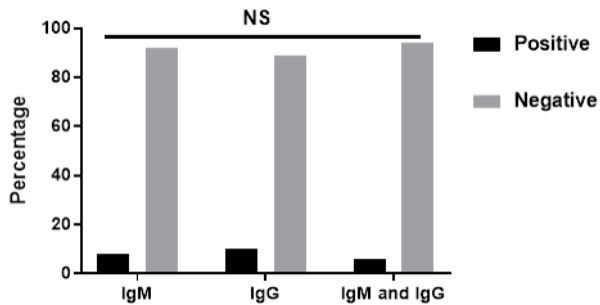
Figure 2. The overall prevalence of Toxoplasma IgM (acute infection) and IgG (chronic infection). Out of 500 pregnant